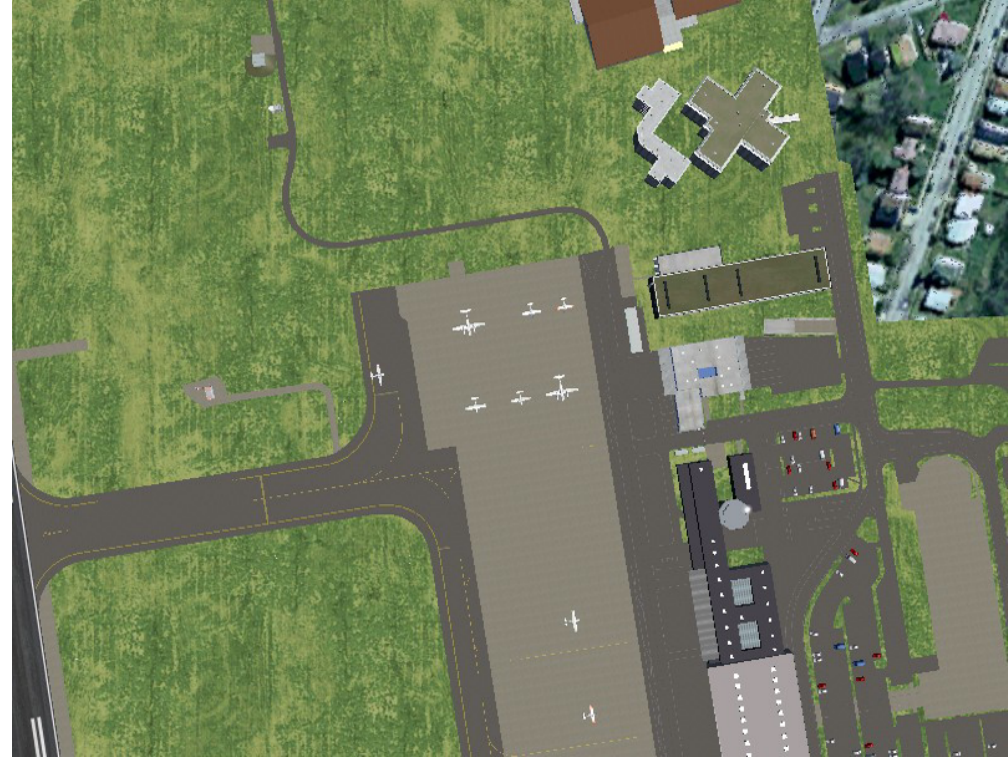
Figure 4. Screenshot of a simulation at the Innsbruck airport using the FlightGear Flight